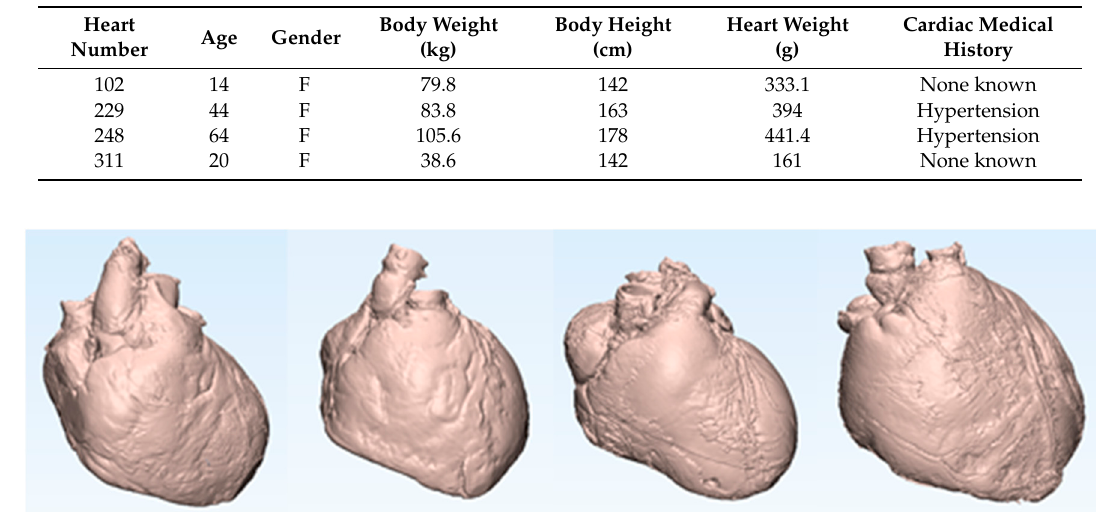
Table 1. Human heart and patient information.